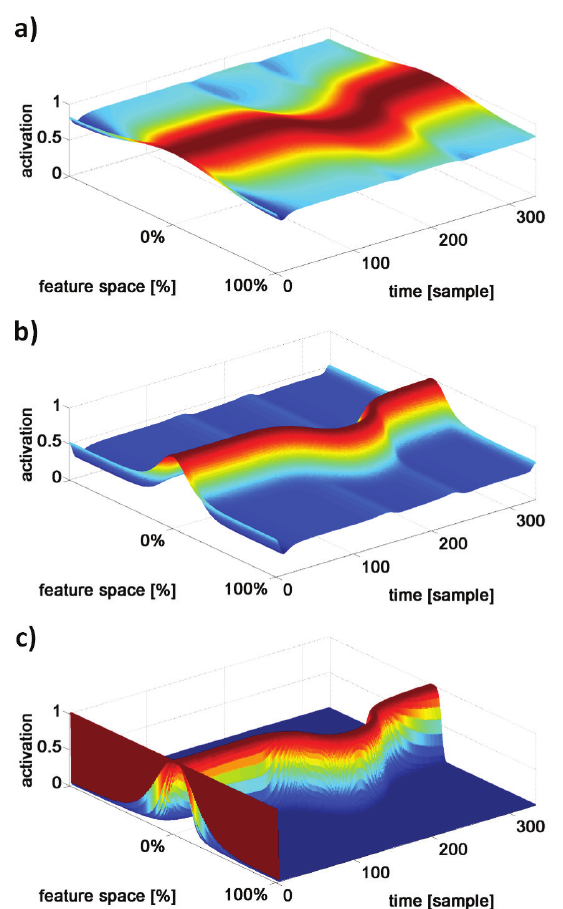
Figure 17. Influence of the adapting kernel for increasing confidence. a) Preshape adapted with a kernel having almost 0% confidence input. b): Confidence is increased to 50%. Finally, c) shows the adapted preshape by 100% confidence, which corresponds the original